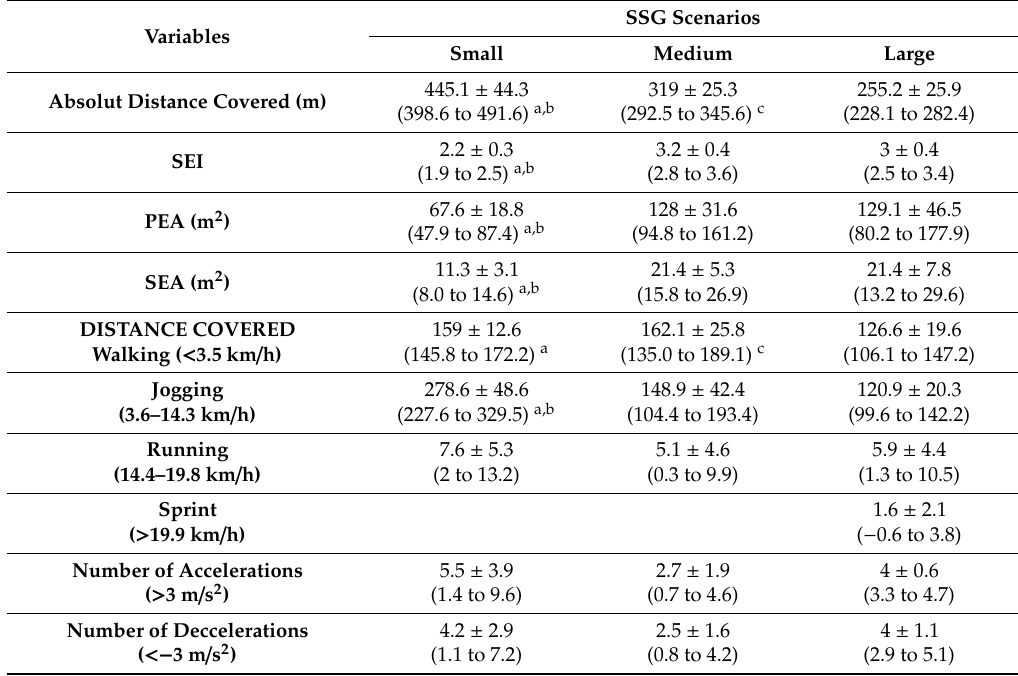
Table 1. Descriptive analysis (mean ± SD) and 95% confidence interval for mean (in parenthesis lower and upper bound).